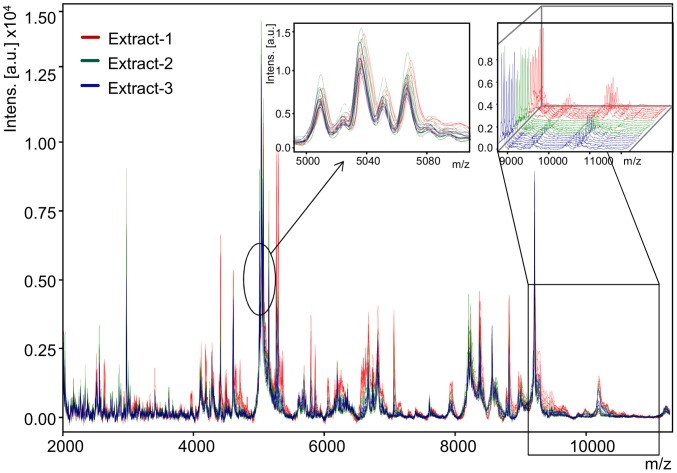
Spectra reproducibility among the biological and technical replicates.Overlay view of 27 spectra obtained from biological and technical replicates of Glossina austeni female whole insect. The masses (in Da) of the ions are shown on the x-axis and the m/z value stands for mass to charge ratio. On the y-axis, the relative intensity of the ions (a.u., arbitrary units) is shown. In the insert, zoomed m/z 5000 to 5200 displays the uniformity among the measured spectra and the stacked view m/z 9000 to 12500 provides a direct comparison of all 27 measured spectra.